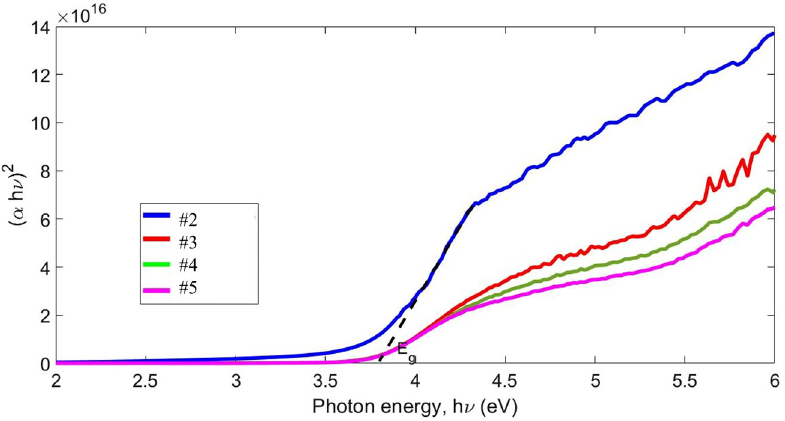
Figure 9. Determination of optical gap band of NiO thin films on quartz substrate with different annealing temperatures.